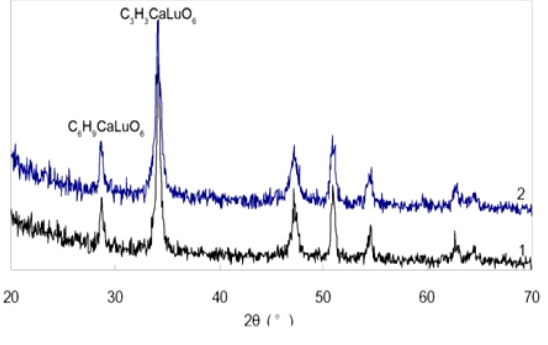
Fig. 4. Sample analysis by X-ray diffractometer Fig. 5. IR spectrum of enhanced/nutrited